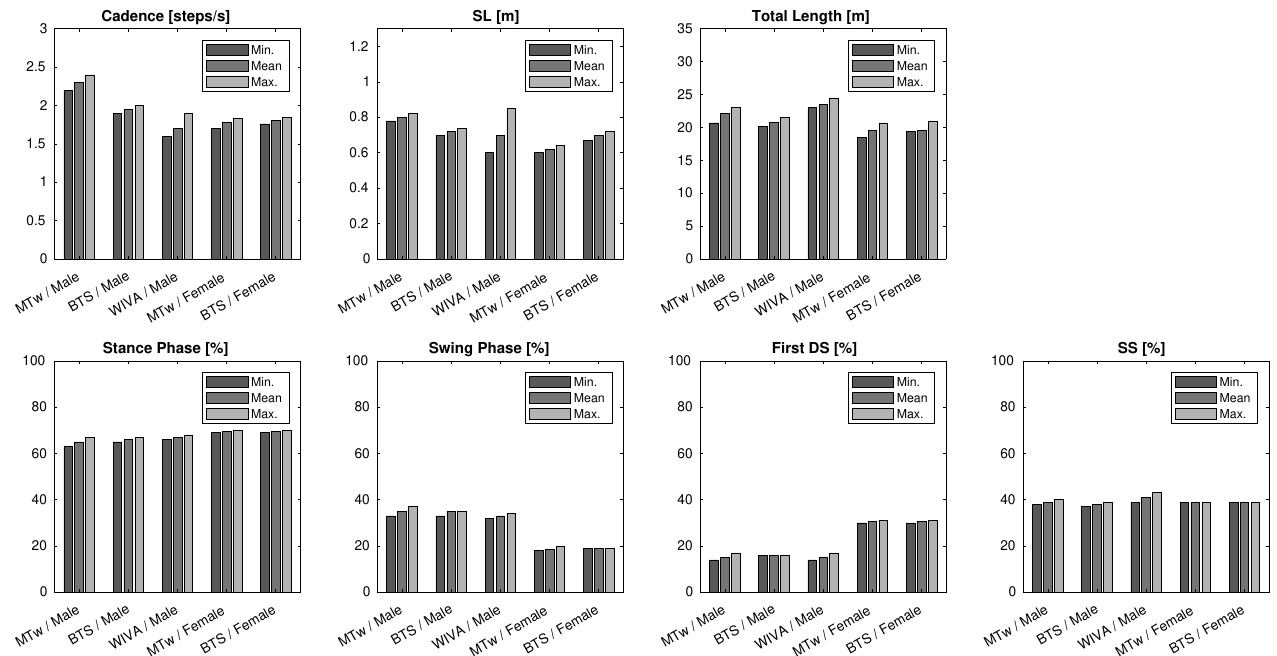
Figure 13. Minimum, mean, and maximum values for the parameters obtained by MTw, BTS, and WIVA in the 10 m Walk Test (6 measurements